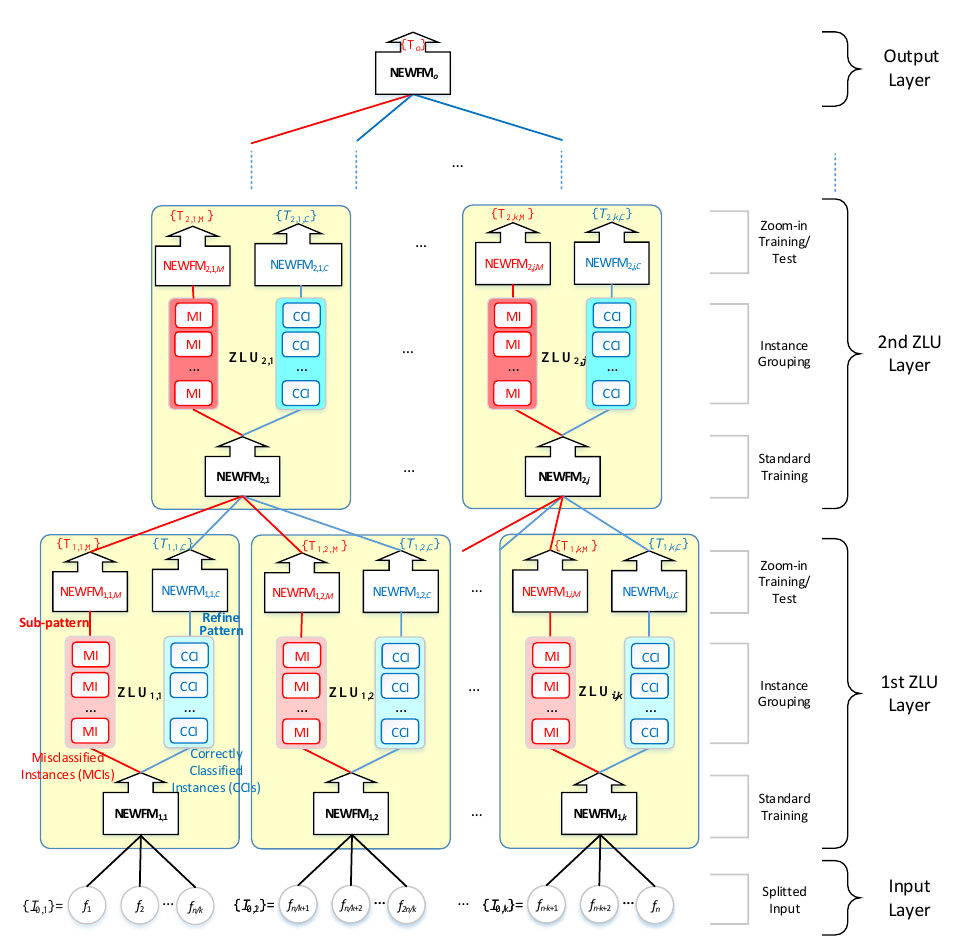
Figure 1. Structure of the Zoom-in Neural Network (ZNN).